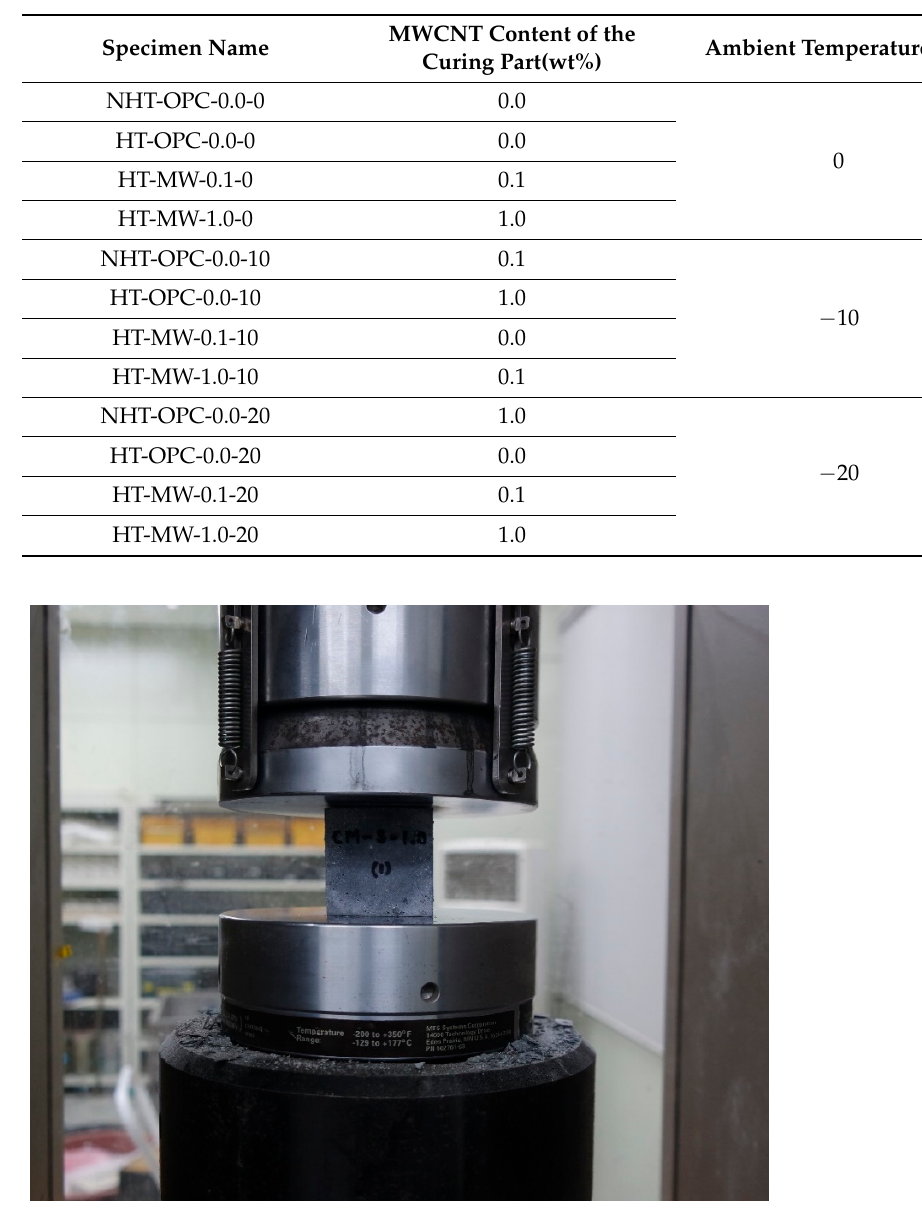
Figure 2. Setup of the compressive strength test of the specimens. The specimen notations are based on the application of heat curing, MWCNT mixing, MWCNT content, and ambient temperature. For simplicity, the following annotations are used hereafter. First, “HT” indicates a heat-cured specimen, and “NHT” a specimen that was left at ambient temperature without heat curing. Second, “OPC” indicates ordinary Portland cement (OPC) without MWCNTs, and “MW” a cementitious composite mixed with MWCNTs. Third, numbers 0.0, 0.1, and 1.0 indicate the MWCNT content relative to the cement weight. Finally, numbers 0, 10, and 20 indicate ambient temperatures of 0 °C, − 10 °C, and − 20 °C, respectively. For example, NHT-OPC-0.0-0 denotes OPC not heat cured but left at an ambient temperature of 0 °C. Similarly, HT-MW-1.0-20 denotes a 1.0 wt% MWCNT cementitious composite heat cured at − 20 °C. The MWCNT cementitious composite was fabricated in accordance with the cement mortar compressive strength test standard ASTM C 109 with a size of 50 × 50 × 50 mm 3 , and 60 specimens were fabricated (five specimens for each parameter set) [32,33]. The curing of the MWCNT cementitious composite was performed by dry-curing to minimize the effect of moisture on both the heating and curing parts.